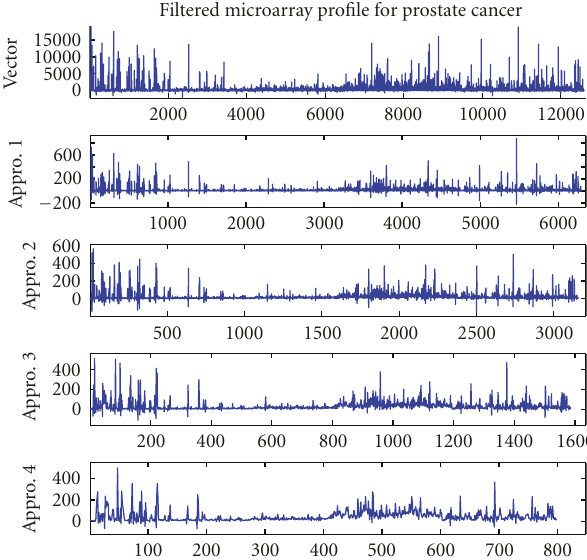
Figure 4: Classification based on wavelet features at 2nd level. N , D w represent the number of samples and dimension number of wavelet features,